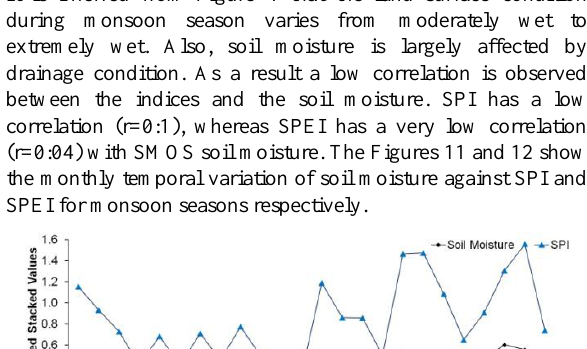
Figure 12. Monthly temporal variation of soil moisture against SPEI during